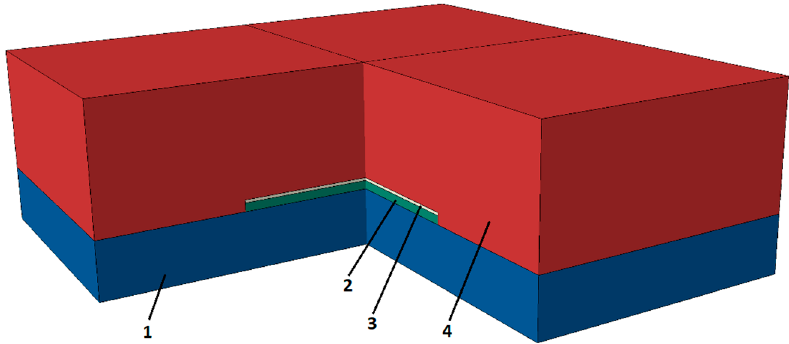
Figure 2. Profile of the simulation model. Part 1 and part 3 are copper layers, part 2 is a silicon layer, and part 4 is the epoxy-amine-based composite, which was divided in eight layers. Table 1. Parts and layer dimensions of the model.